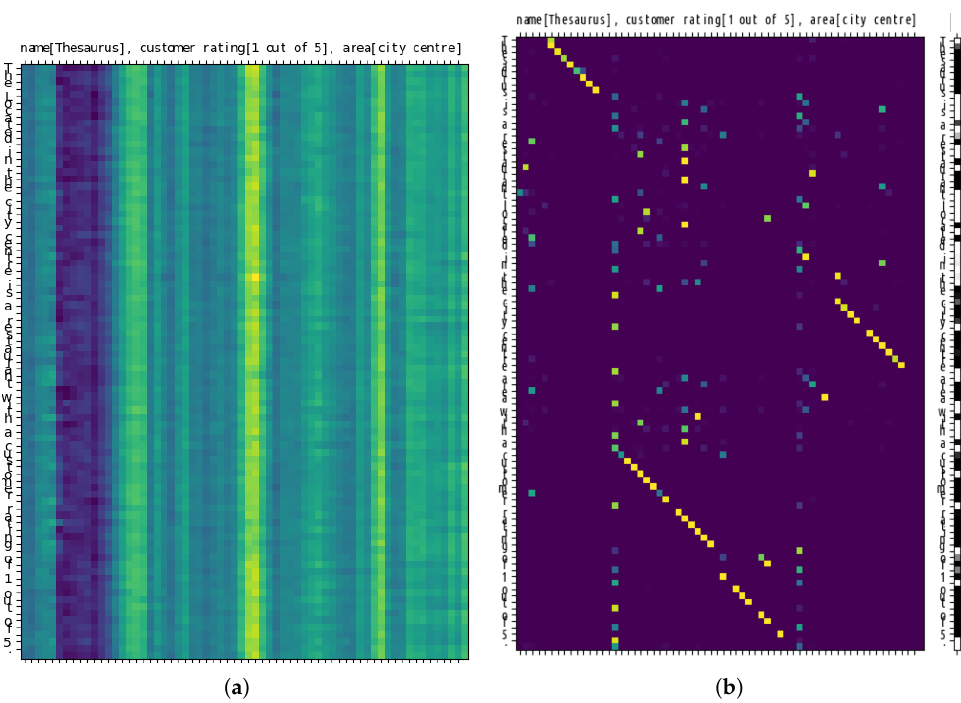
Figure 3. Attention matrix of the two models when presented with the input “name[Thesaurus], customer rating[1 out of 5], area[city centre]”. In the x axes, there is the input sequence. In the y axes, there is the output sequence. Every i th row is the attention distribution that was used to output the i th token. Therefore, the value in position ( i , j ) is the “focus” value over the j th character when the i th letter was given in the output. Light dots mean higher attention than dark ones. ( a ) ED+A model. ( b ) Encoder–Decoder model with Attention, Copy, and Shift (ED+ACS). The column on the right shows the p i gen values for every time step, black being near 0 and white near